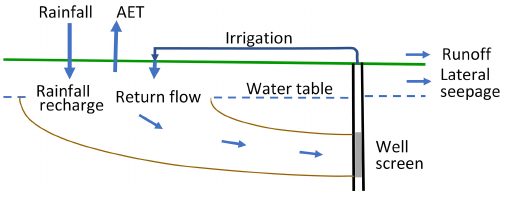
Figure 9. Schematic view of recharge and irrigation return flow in the Tinwald